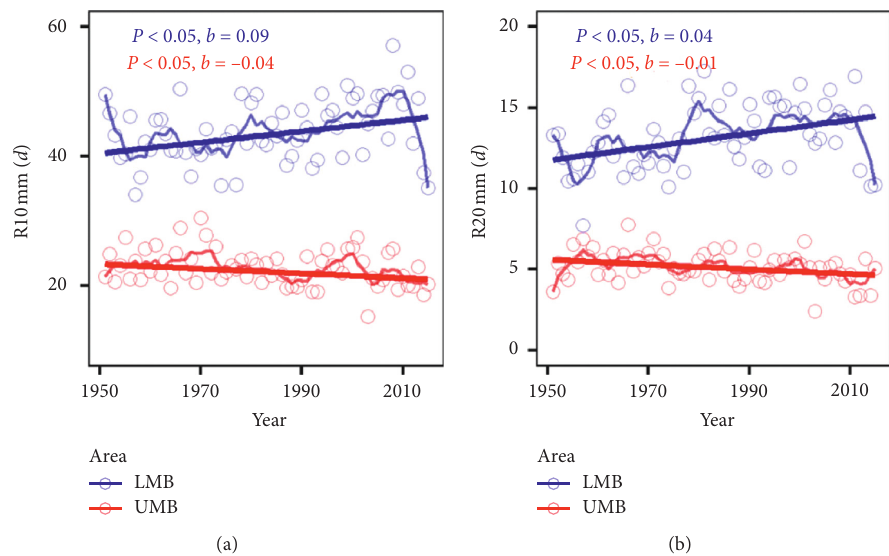
Figure 3: Temporal trends in R10mm and R20mm averaged across the UMB and the LMB over 1951–2015. The lines represent linear trends of precipitation indices, and the polylines indicate the five-year moving averages of the indices.